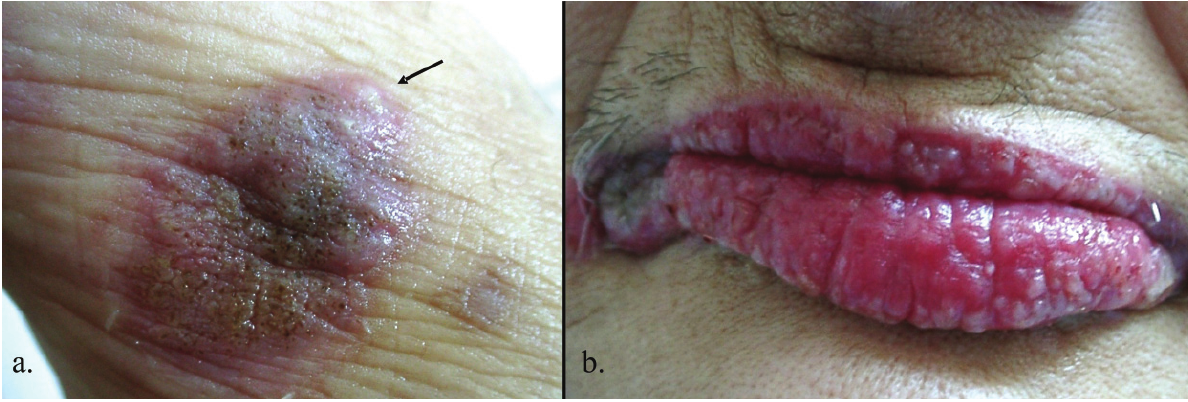
Figure 2 - a. verrucous plaque on the right foot, note the pustule on the periphery (arrow) b. verrucous aspect of the